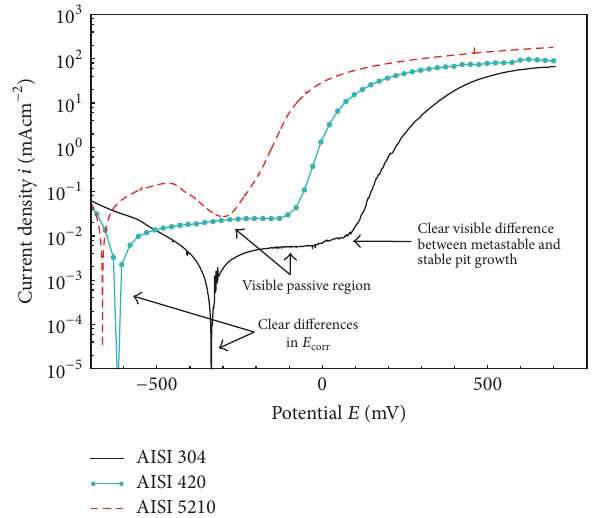
Figure6:PotentiodynamicpolarizationscansofAISI304,AISI420, and AISI 5210 in phosphate buffer with 3.5 wt.%